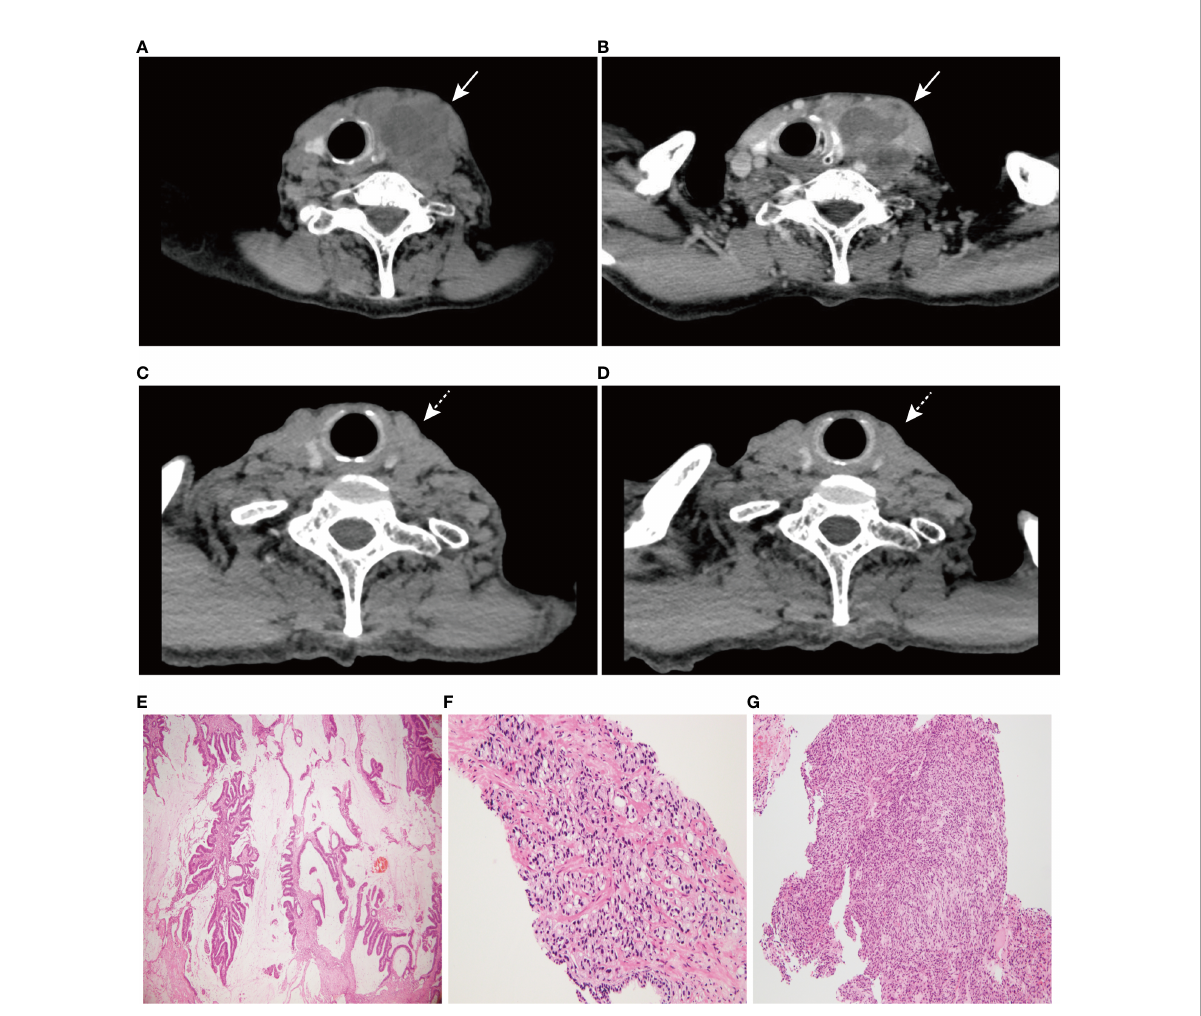
FIGURE 1 CT scan images of neck and hematoxylin-eosin (HE) staining of three tumors (×100). (A) A 66 mm×54 mm round soft tissue mass shadow in the left neck. (B) Further contrast-enhanced CT scan showed ring enhancement. (C) CT scan image of neck at 6 months post-treatment. (D) CT scan image of neck at 10 months post-treatment. (E) HE staining of rectal mucinous adenocarcinoma, (F) prostate adenocarcinoma, and (G) undifferentiated sarcoma of the left neck. Solid arrows indicate tumor masses; dashed arrows indicate signi fi cant tumor